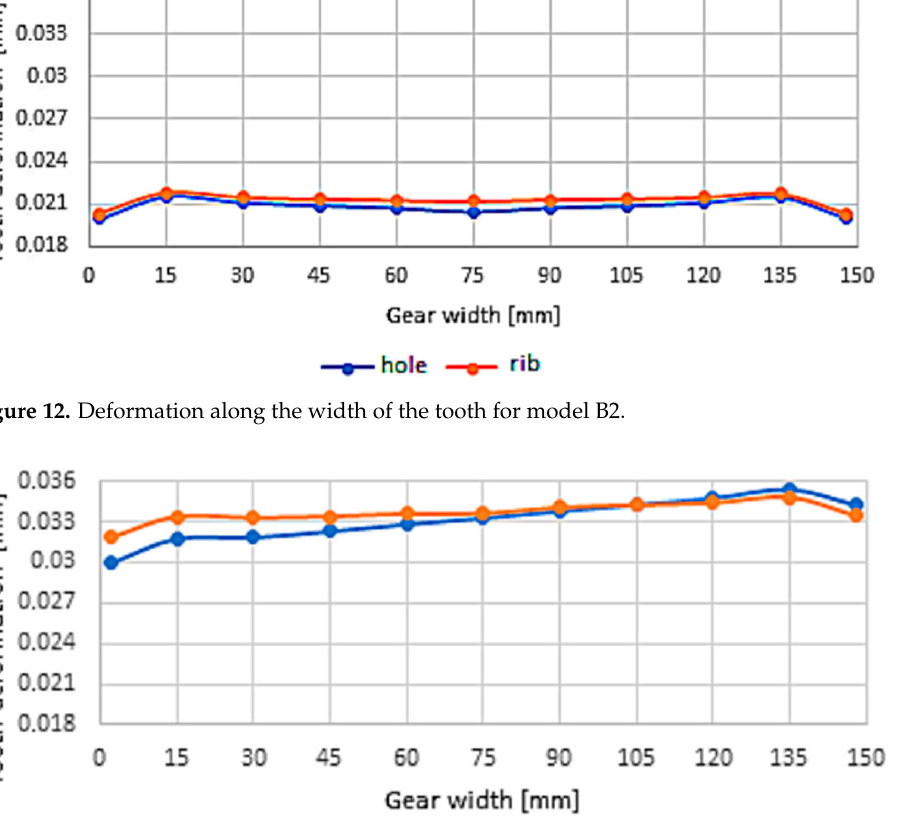
Figure 14. Deformation along the width of the tooth for model B4.